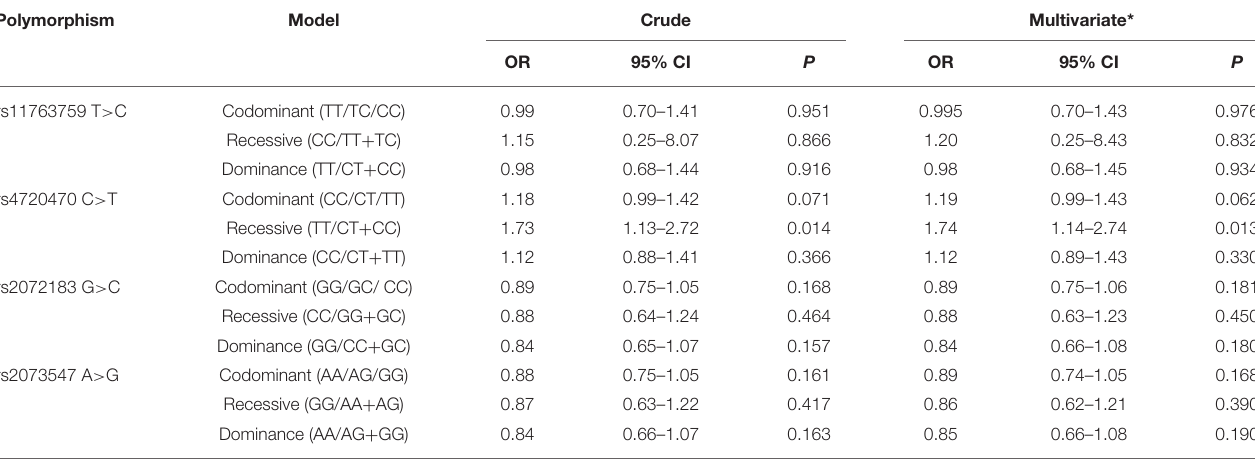
TABLE 3 | Univariate and multivariate adjusted logistic regression analysis of NPC1L1 gene SNPs and the risk of PTVD.